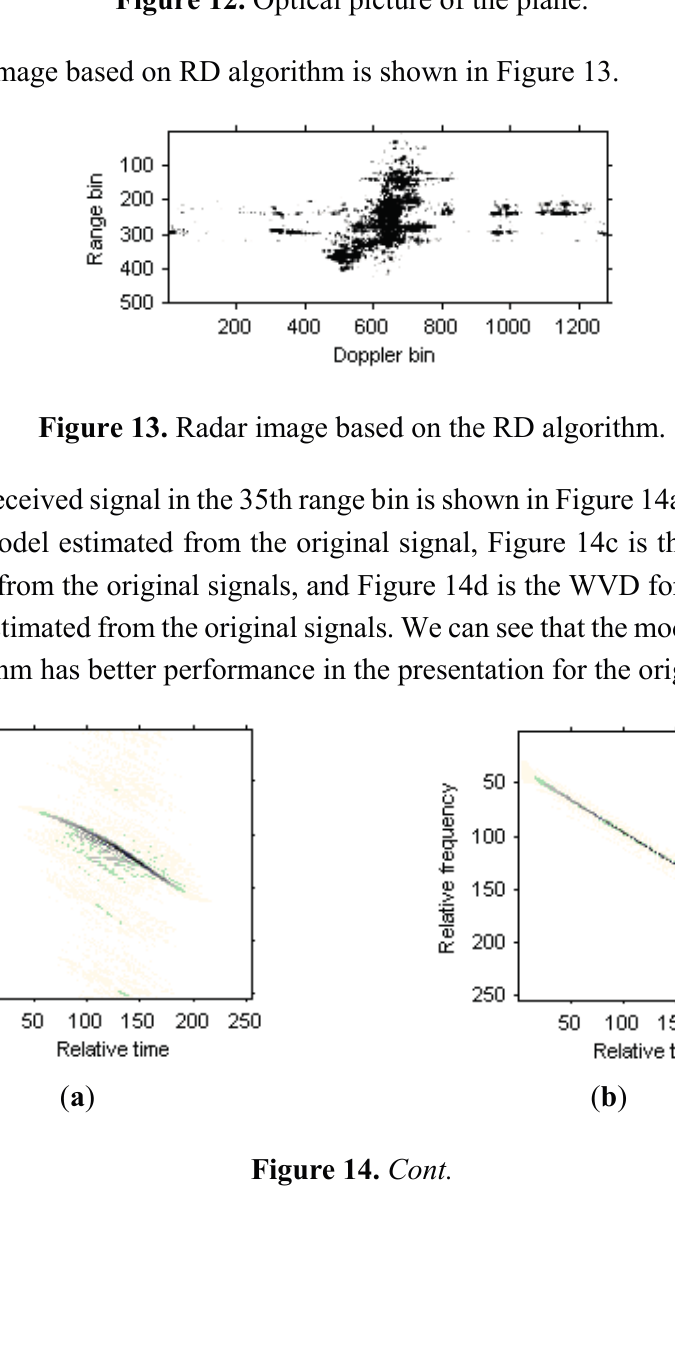
Figure 12. Optical picture of the plane.